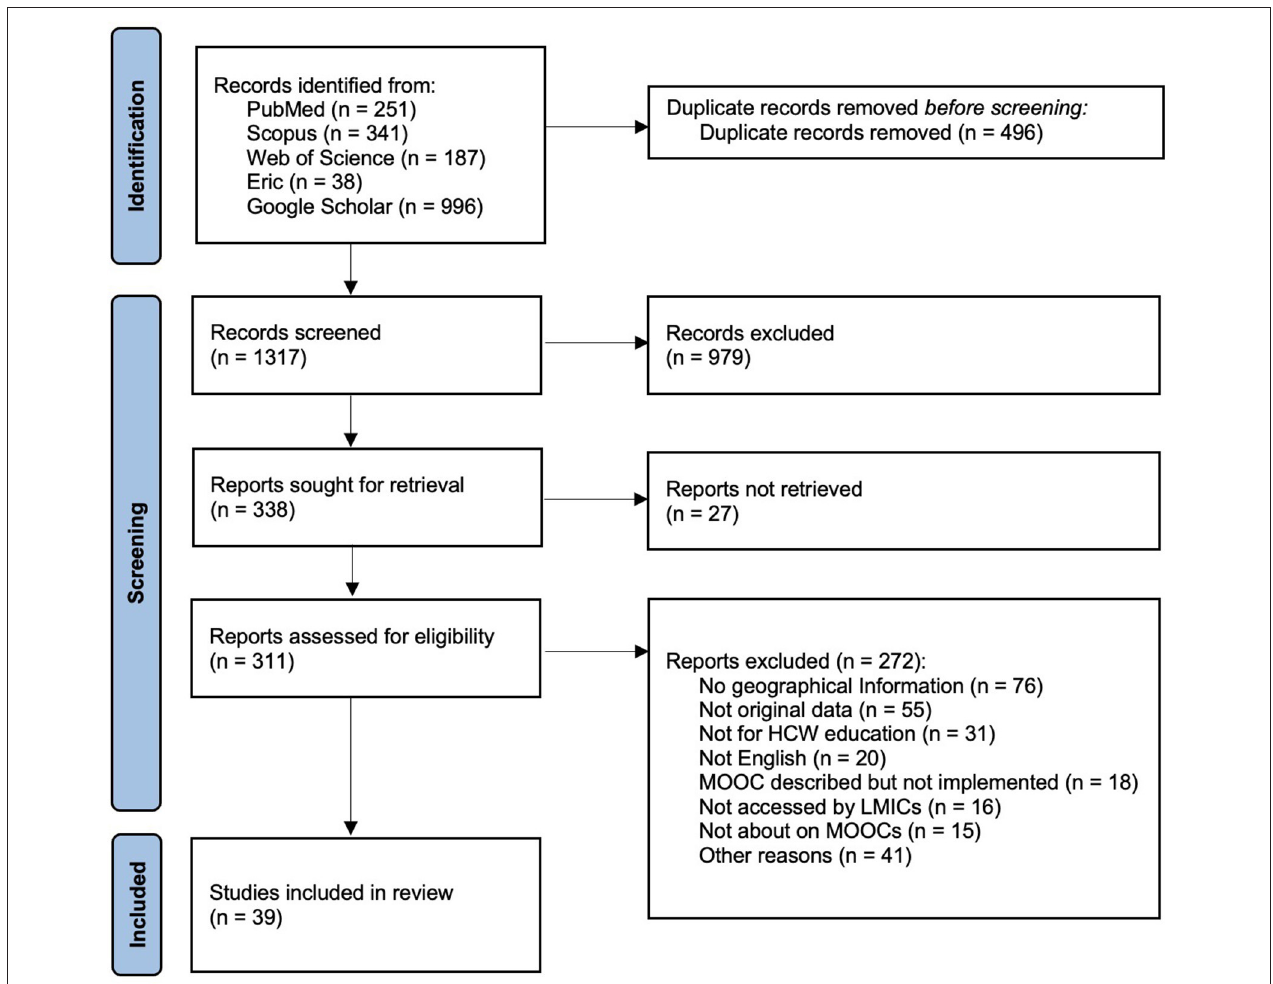
FIGURE 1 | PRISMA flow